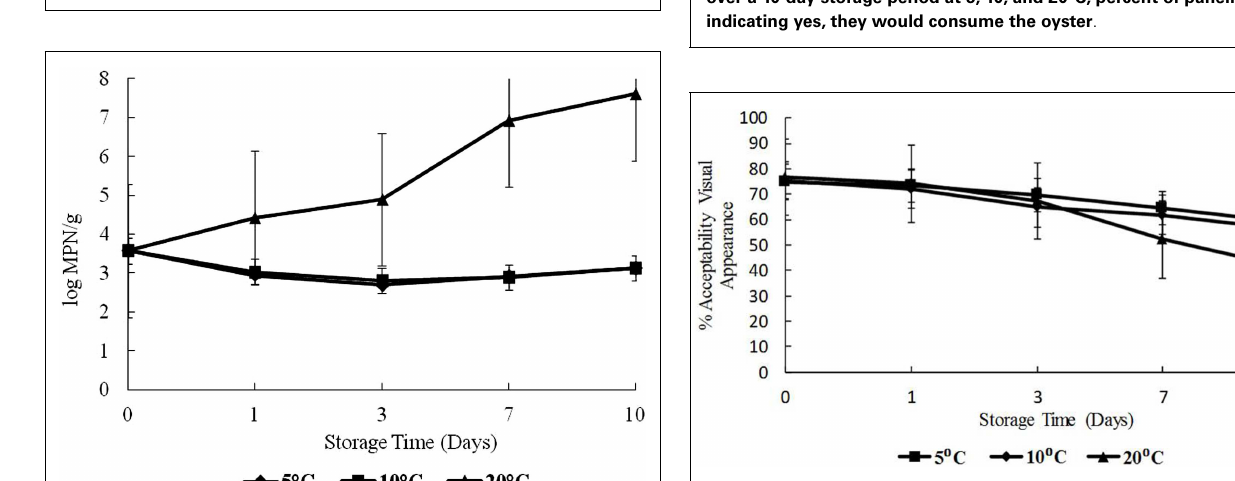
FIGURE 2 | Levels of total vibrios during 10days of storage at 5, 10, and 20°C .